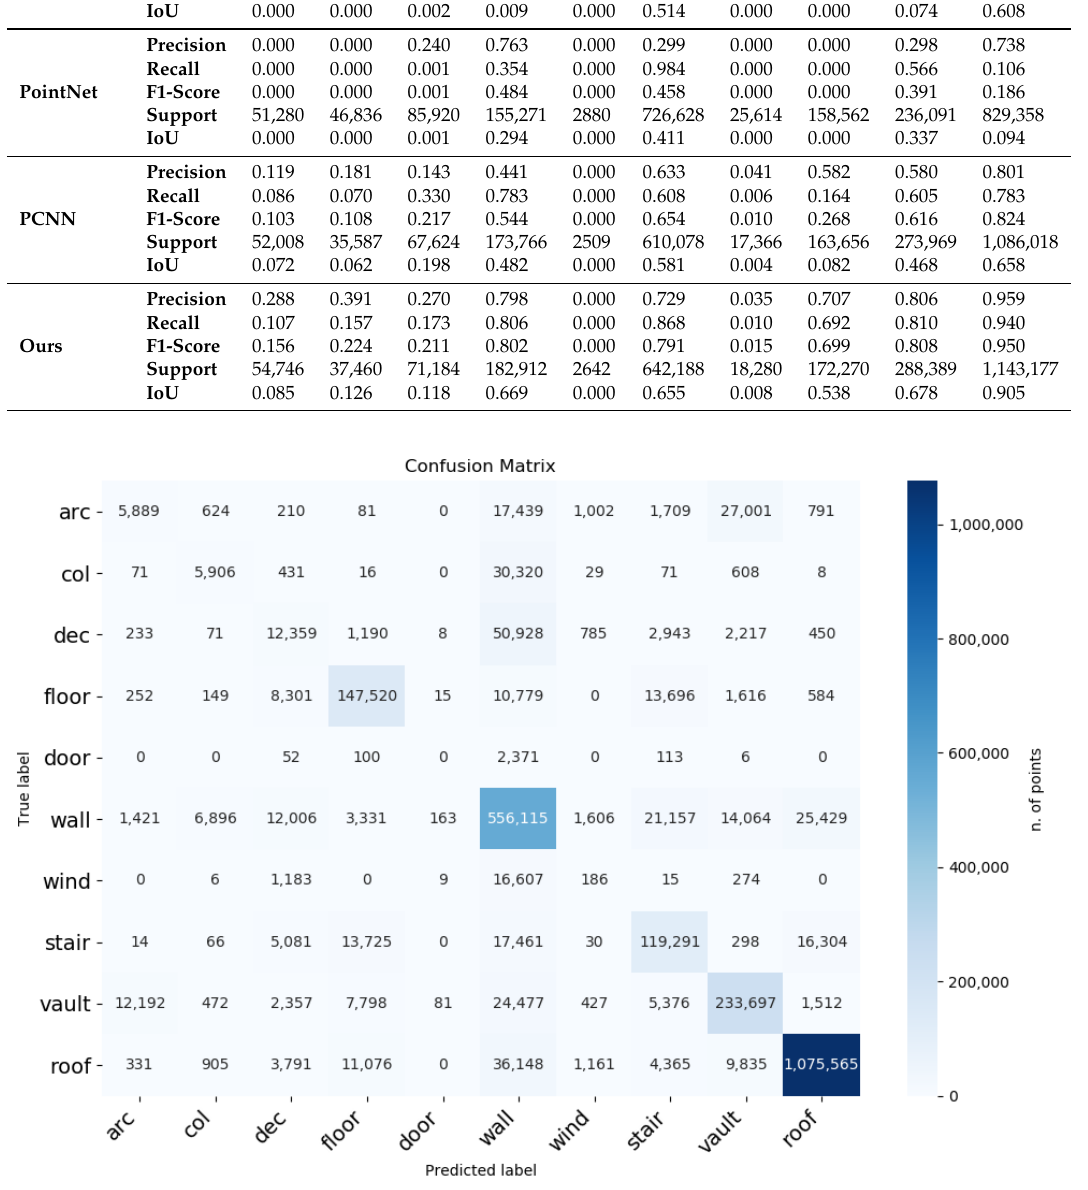
Figure 6. Confusion matrix for the last experiment: 9 scenes for Training, 1 scene for Validation and 1 scene for Test. The darkness of cells is proportional to the number of points labeled with the corresponding